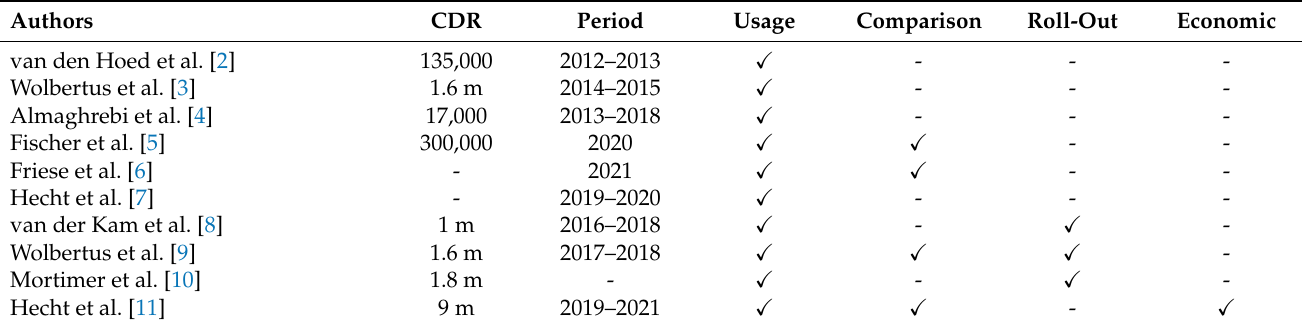
Table 1. Overview Related